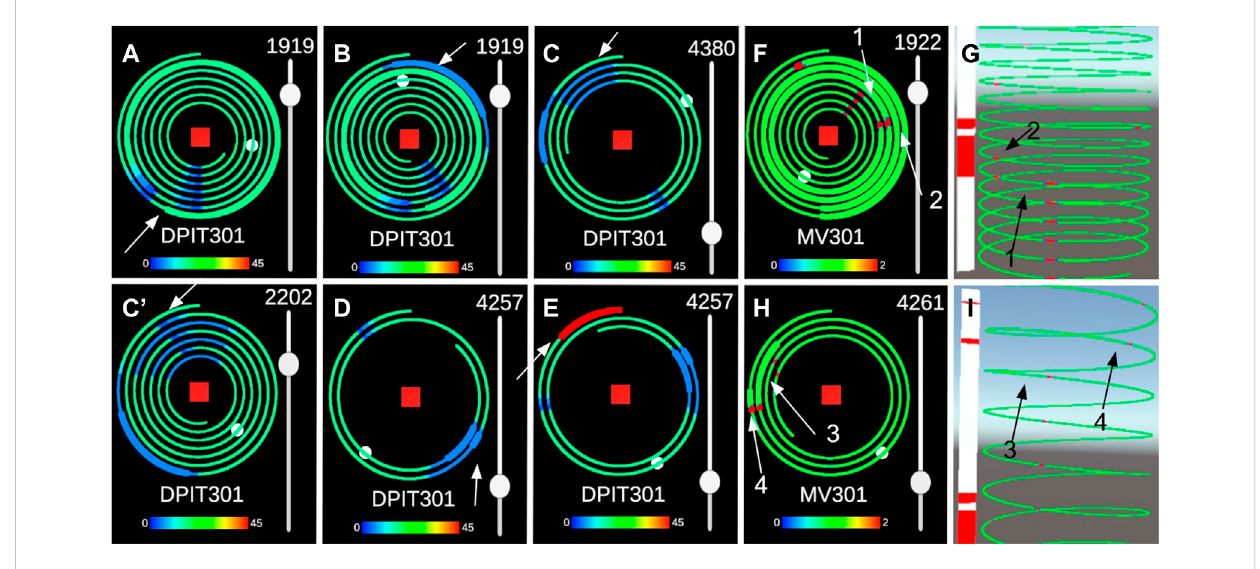
FIGURE 6 Alertsofsets1arerepresentedwiththe2Dinterface (A,B,C,C 9 ,D,E) . (C 9 ) representsthesamealertas (C) withhalftheperiod.Thepatternof “